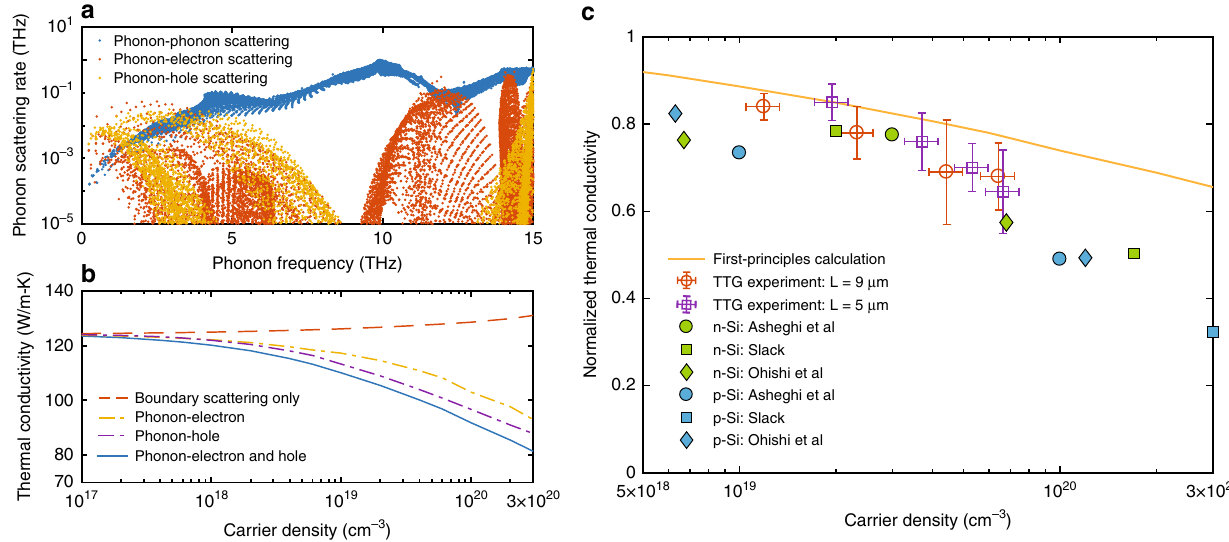
Fig. 3 Comparison between experiment and fi rst principles calculation. a First-principles computed phonon scattering rates due to phonon – phonon interactions, phonon – electron interactions, and phonon – hole interactions as functions of the phonon frequency. The carrier density for electrons and holes is taken as 6 × 10 19 cm − 3 . At this carrier concentration, electrons and holes dominantly scatter long wavelength phonons with frequency <3 THz. b Computed total thermal conductivity with carrier density including lattice, electronic, and bipolar contributions. The dashed line indicates the total thermal conductivity of the silicon membrane, of which the lattice contribution considers only phonon boundary scatterings and intrinsic phonon – phonon interactions. Other curves further consider the interactions of phonons with electrons, with holes, and with electron – hole pairs together, respectively, when modeling the lattice contribution. At the carrier concentration of 1 × 10 20 cm − 3 , the predicted total thermal conductivity including all scattering mechanisms (blue curve) is 92 W m − 1 K − 1 , which is reduced by about 25% from the pristine value (124 W m − 1 K − 1 , corresponding to low carrier density). Details of the calculation are given in the “ Methods ” section. c Normalized thermal conductivity with the carrier density, showing general agreement between experiment and fi rst principles calculation. Each data point is averaged over at least two locations, and we have performed experiments with two different grating periods (5 and 9 μ m). The uncertainty represents the standard deviation of the measurement results. The fi rst-principles result is obtained from the solid blue curve in b after normalizing to the value for the pristine membrane. Also shown are the thermal conductivities of doped silicon samples with different doping concentrations from past